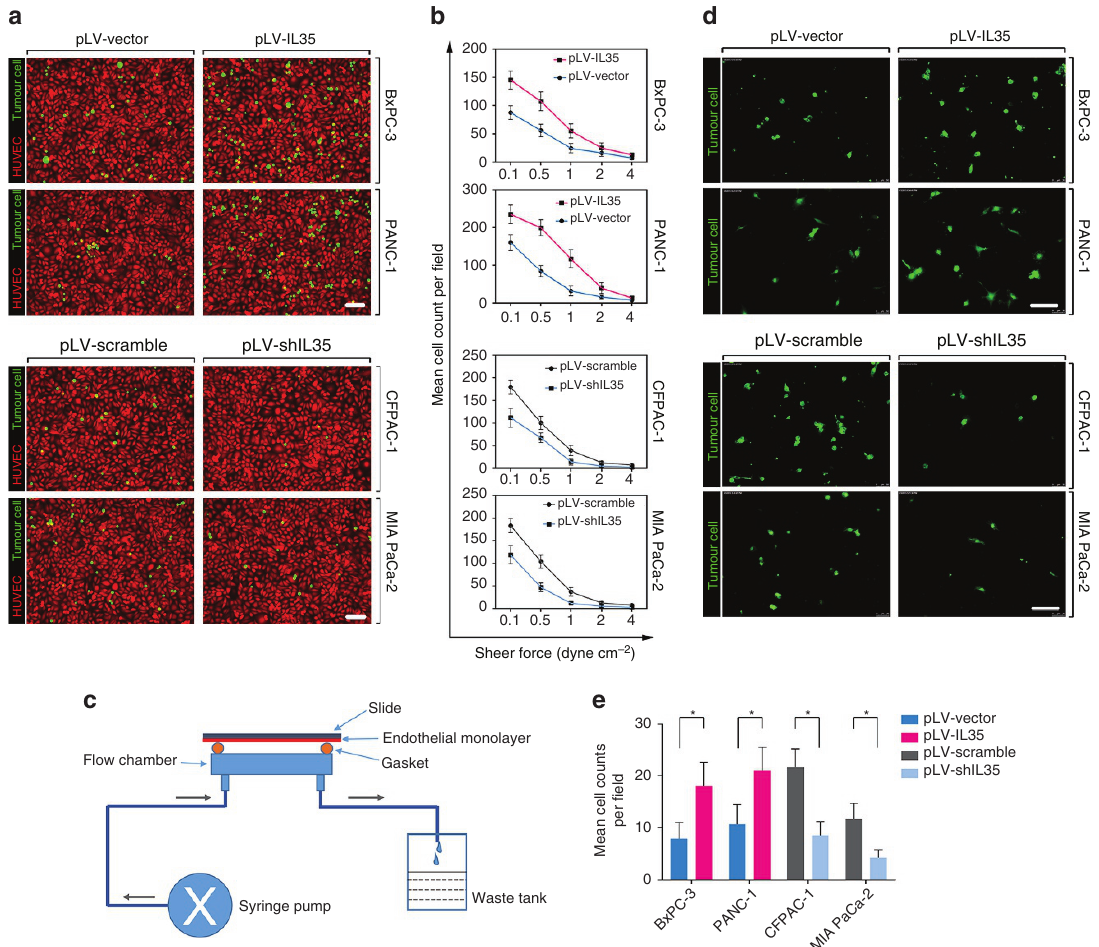
Figure 2 | IL-35 facilitates PDAC cell endothelial adhesion and TEM in vitro . ( a ) Representative immunofluorescence images demonstrating the dynamic flow assays at the shear force of 1dynecm (cid:2) 2 . ( b ) Adhesion-shear force curves of the adhesion assays performed at shear forces from 0.1 to 4dyne cm (cid:2) 2 . ( c ) Schematic diagram of the dynamic flow assay kit. ( d , e ) The indicated tumour cells were seeded on HUVEC monolayers reaching confluence in 24-well Transwell inserts. After incubation for 12h, the transmigrated tumour cells were imaged. The experiments were replicated three times; shown are the means ± s.d. Unpaired t -tests were used in b and e . Tests of significance are two-sided. * P o 0.05. Scale bars, 100 m